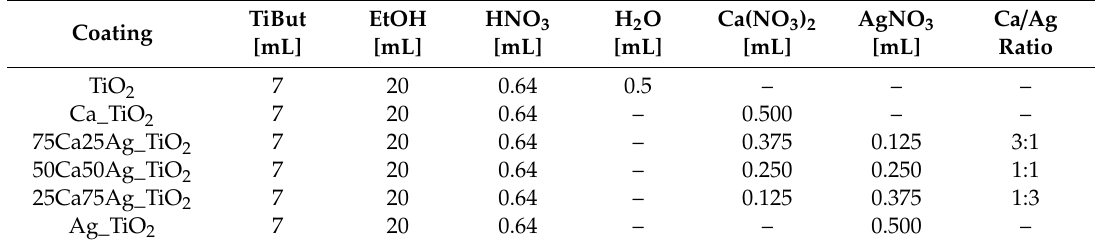
Table 1. Composition of sol solutions used for surface modification of M30NW